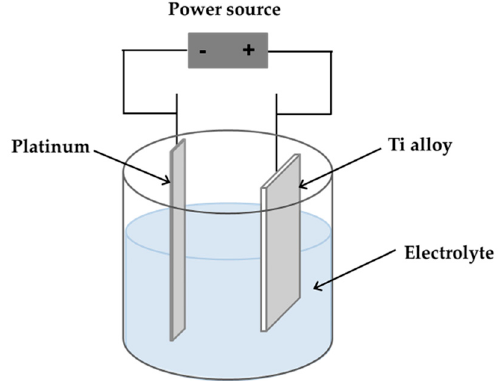
Figure 1. Schematic illustration of the anodization equipment.